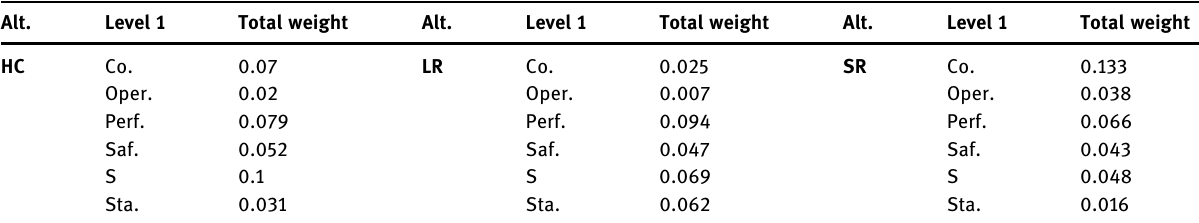
Table 2: The local and global contributions of each property of the model and their sums Alt.